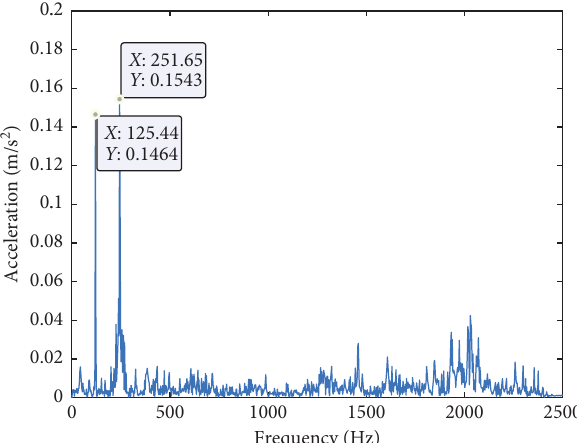
Figure 6: Frequency spectra of the acceleration signal before cutting as shown in Figure 5.